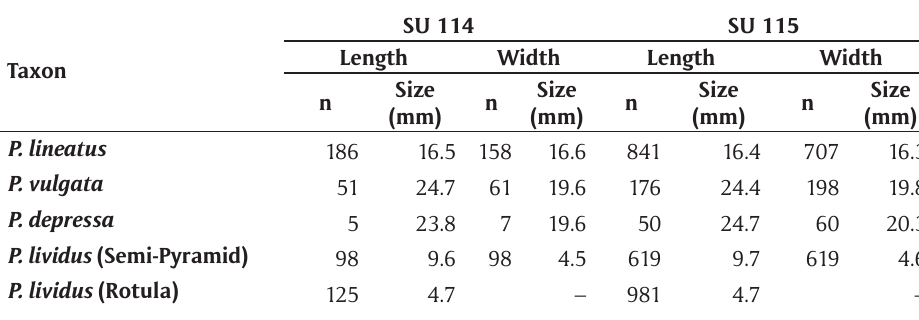
Figure 5: Collection areas in units 114 and 115 regarding coastal exposure (exposed or